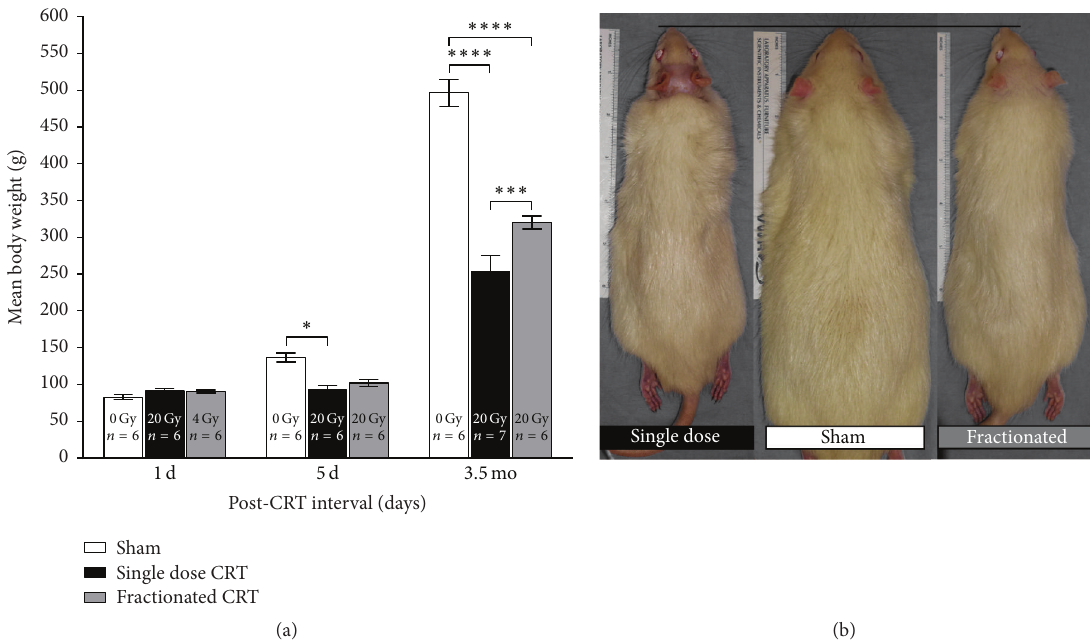
Figure 5: (a) Mean body weights ( ± SEM) 1d, 5 d, and 3.5 mo after CRT [ ∗ 𝑝 < 0.05 , ∗∗∗ 𝑝 < 0.001 , ∗∗∗∗ 𝑝 < 0.0001 ]. Note that all animals are age-matched at each post-CRT interval and that 24 hours after the start of radiation the single dose CRT and fractionated CRT groups differ only in terms of the cumulative dose of radiation received. (b) Representative images of a rat from each group 3.5 mo after radiation demonstrate the dramatic retardation of body growth as a consequence of radiation. Note also the permanent effect of single dose radiation on hair growth on the dorsal surface of the region of the head directly in the field of